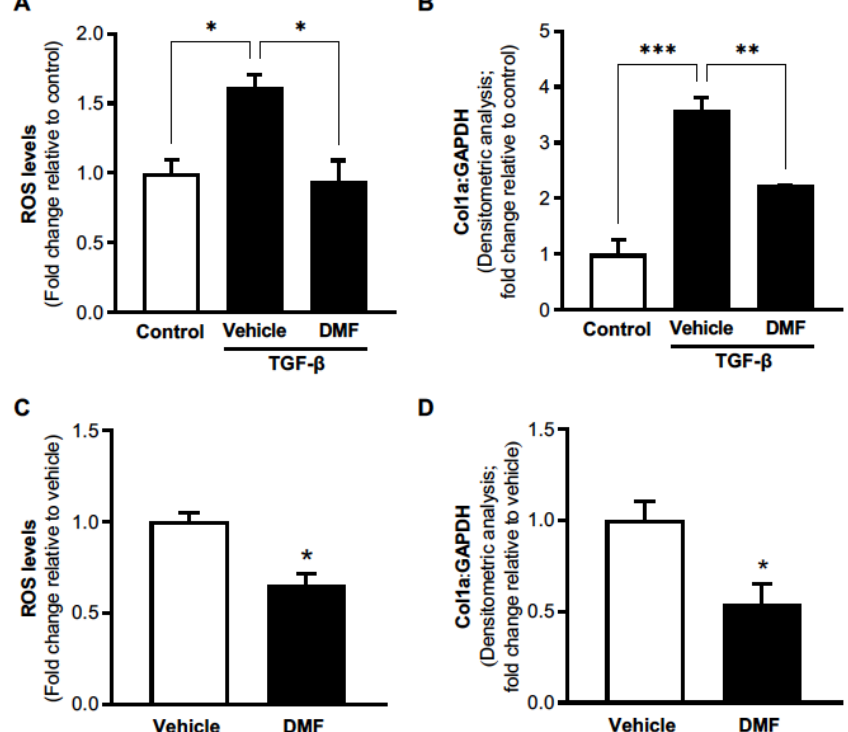
Figure 1. DMF treatment inhibits pro-fibrotic phenotypes in IPF lung fibroblasts. Primary fibroblasts were isolated from the lung of a patient with biopsy-proven IPF. ( A , B ) IPF lung fibroblasts were treated with DMF (1 µ M) or vehicle (DMSO) followed by treatment ± TGF- β (2 ng/mL). H 2 O 2 levels were evaluated at 24 h by Amplex Red assay ( A ), and whole-cell lysates were assessed for collagen-1 α expression at 48 h by Western blot; densitometric analyses are shown ( B ). ( C , D ) IPF lung fibroblasts were treated with DMF (1 µ M) or vehicle (DMSO). Culture supernatant was evaluated for H 2 O 2 levels at 24 h by Amplex Red assay ( C ), and whole-cell lysates were assessed for collagen-1 α expression at 24 h by Western blot; densitometric analyses are shown ( D ). All values represent means ± SEM; technical replicates ( n = 3); * p < 0.05; ** p < 0.01; *** p < 0.01 using Student’s two-tailed t -test to compare the means between two groups and one-way ANOVA multiple comparisons with a Tukey’s post -test to compare the means among three groups.